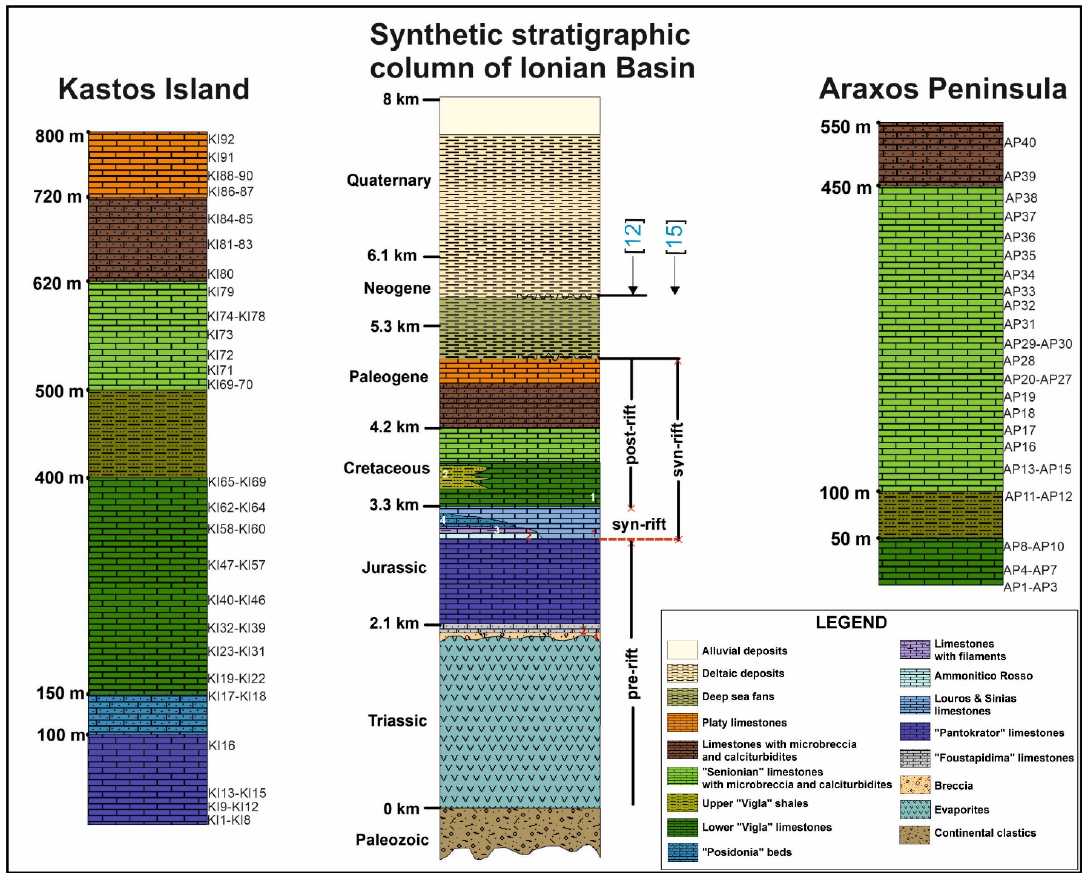
Figure 2. Detailed synthetic lithostratigraphic columns of Cretaceous deposits, from NW Peloponnesus and Kastos Island, in relation with the synthetic stratigraphic column of Ionian zone (modified from [12]).